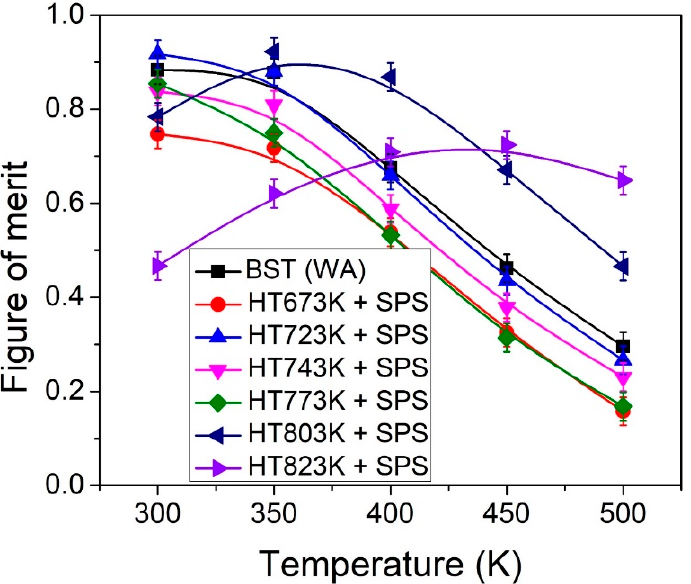
Figure 6. Temperature dependence of dimensionless figure of merit, ZT, for the bulk samples obtained by powder heat treatment at different temperatures and consolidation.